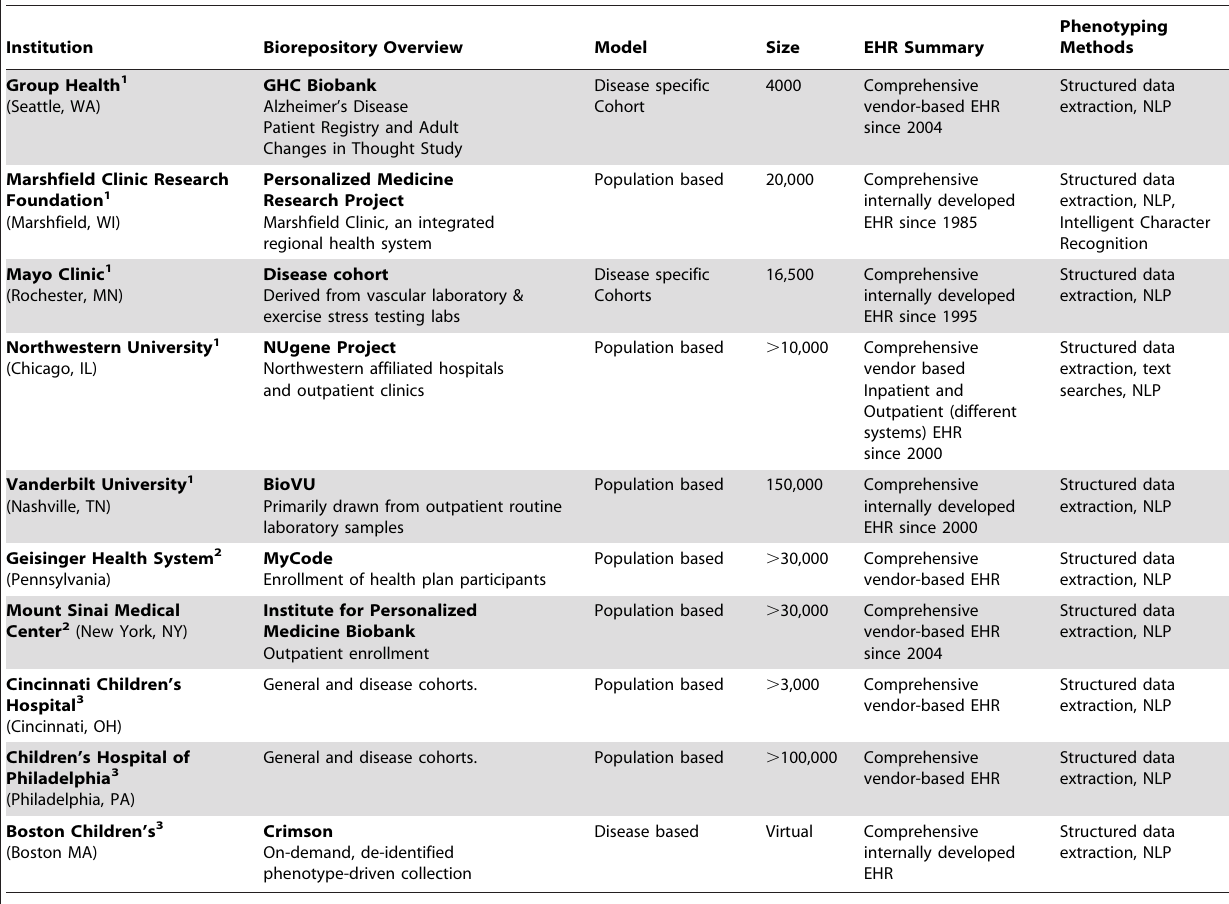
Table 3. eMERGE network